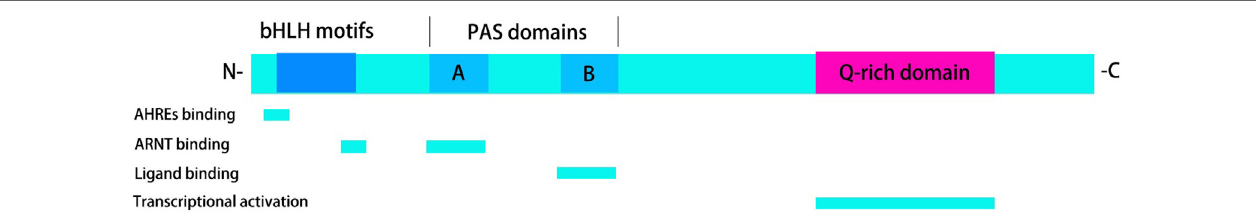
FigURe 1 | Functional structure of the aryl hydrocarbon receptor (AhR). The functional structure of the AhR protein consists of three parts: the basic helix–loop–helix (bHLH) motifs, the Per-ARNT-Sim (PAS) domains, and a Q-rich domain. bHLH motifs are involved in the activity of aryl hydrocarbon response elements (AHREs) binding and AhR nuclear translocator (ARNT) binding. PAS domains are required for ARNT binding and ligand binding. Transcriptional activation can be observed in Q-rich domain.